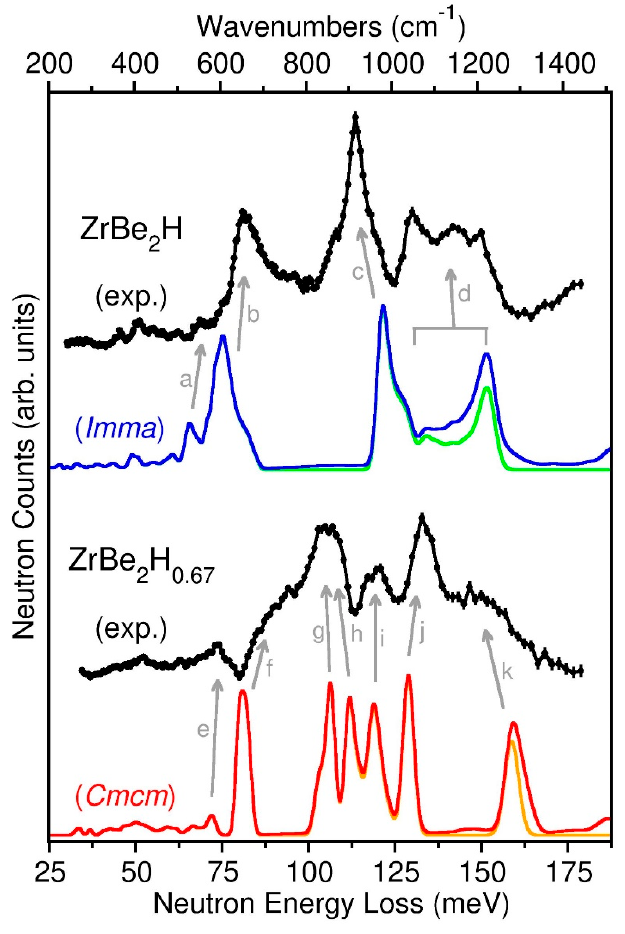
Figure 8. Comparison of the 10 K neutron vibrational spectra (black) for orthorhombic ZrBe 2 H (iden- tical to the ZrBe 2 H 0.9 sample spectrum) and ZrBe 2 H 0.67 (derived by subtracting the minor ZrBe 2 H fraction from the ZrBe 2 H 0.6 sample spectrum) with the simulated 1 + 2-phonon spectra for the 0 K density-functional-theory-optimized structures of Imma -ordered ZrBe 2 H (blue) and Cmcm -ordered ZrBe 2 H 0.67 (red) assuming full occupancies for the H sites designated in Figures 2 and 4. Green and orange curves denote the corresponding 1-phonon spectra. Arrows provide a guide for relating simulated peak intensities to the experimental scattering features. ( N.B. , 1 meV ≈ 8.0655 cm − 1